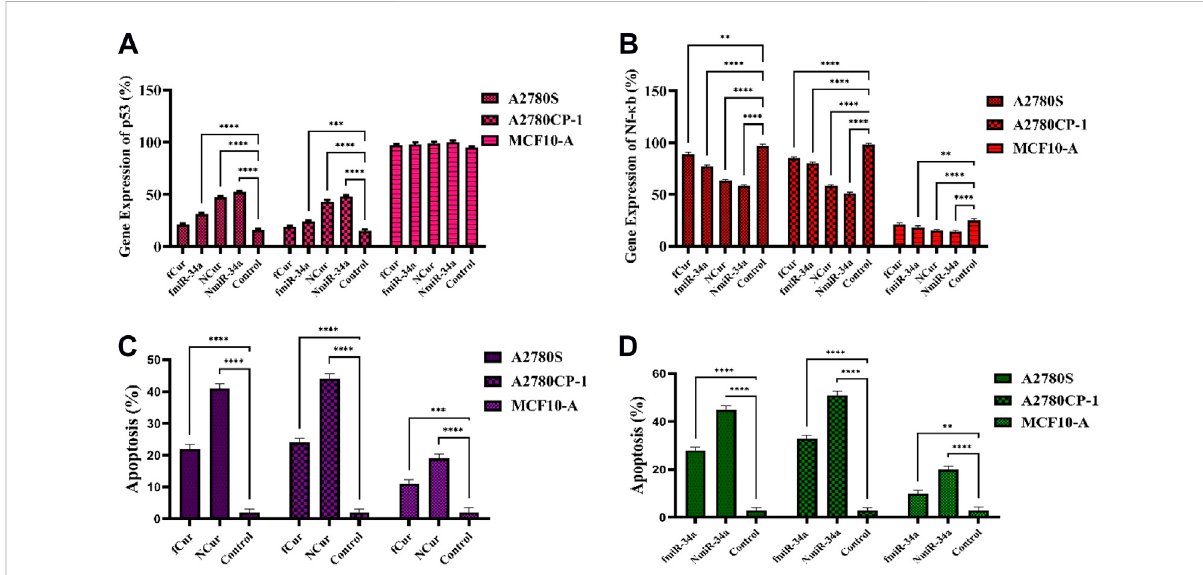
FIGURE 9 (A,B) The real-time PCR analysis of the expression of p53 and Nf- ĸ B genes subjected to the samples for 48 h (C,D) Apoptosis assay of cells subjected to the samples using fl ow cytometry after 24